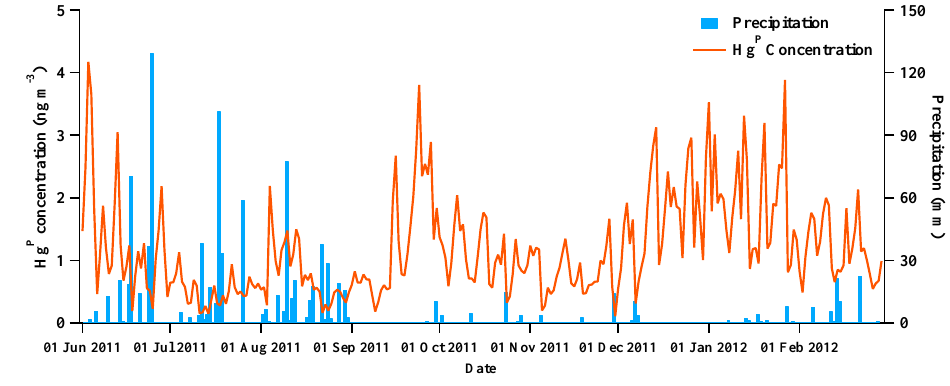
Fig. 5. Hg P concentration and precipitation during the study